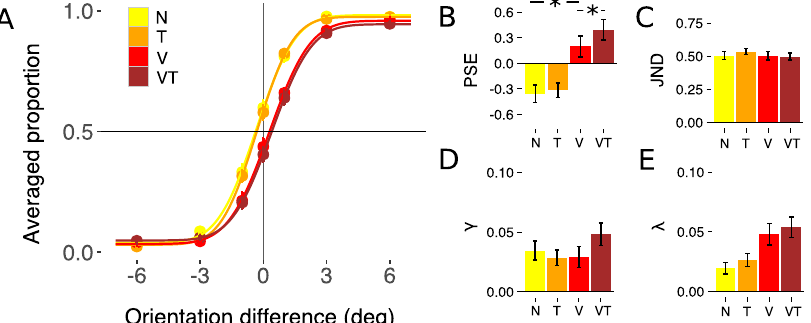
Figure 2. Orientation discrimination performance ( A ) Group averaged choice probability data and group level psychometric functions for each surround condition (None, Tactile-only, Visual-only and Visuo-tactile). Mean of the group distribution of individual PSE ( B ) JND ( C ) γ ( D ) and λ ( E ) parameters. Error bars represent standard error. Asterisks represent those hypothesis-driven contrasts that showed a significant effect.